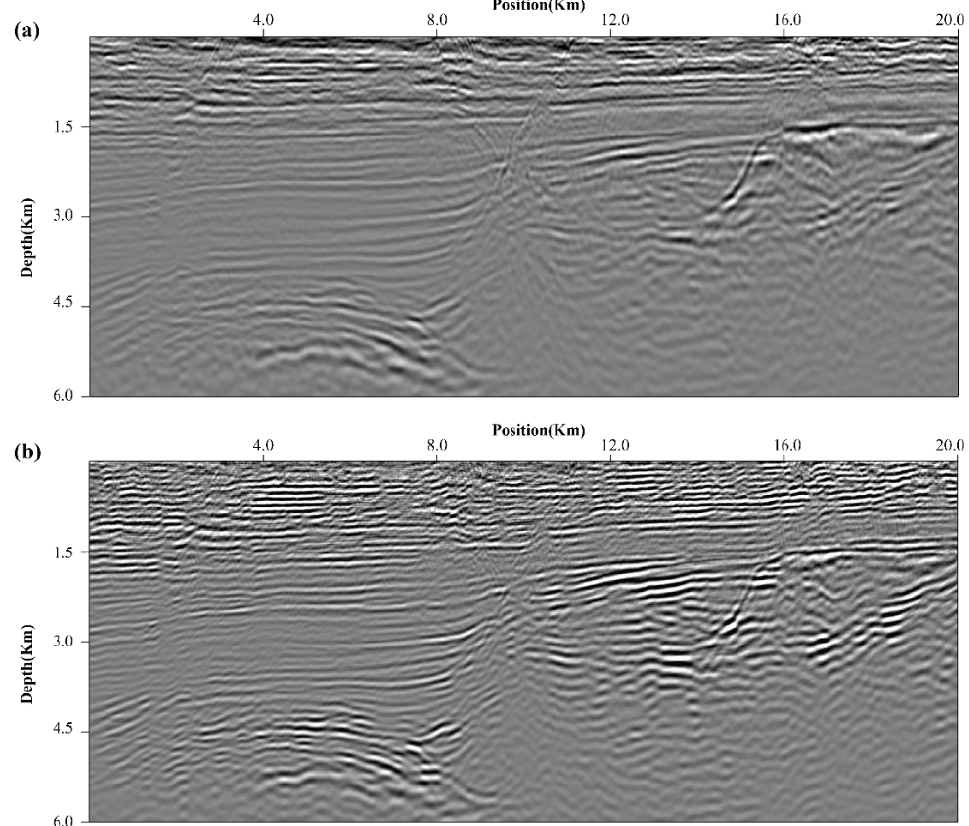
Figure 13. Comparison of the stack images of reflection angle from 0 to 50° by using ( a ) Method 1 and ( b ) Method 4. All images are regularized to the same amplitude scale.